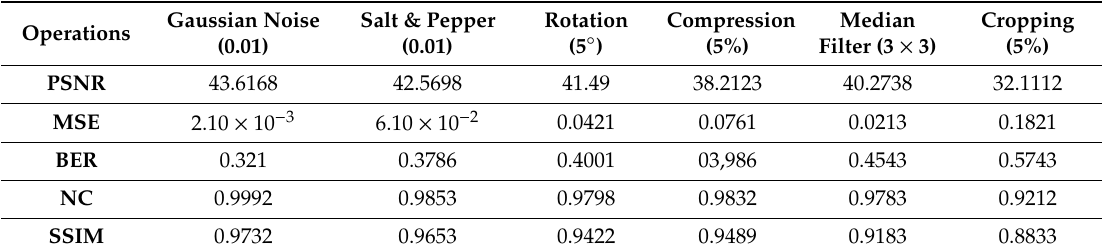
Table 4. Quality of extracted watermark after different image-processing operations .